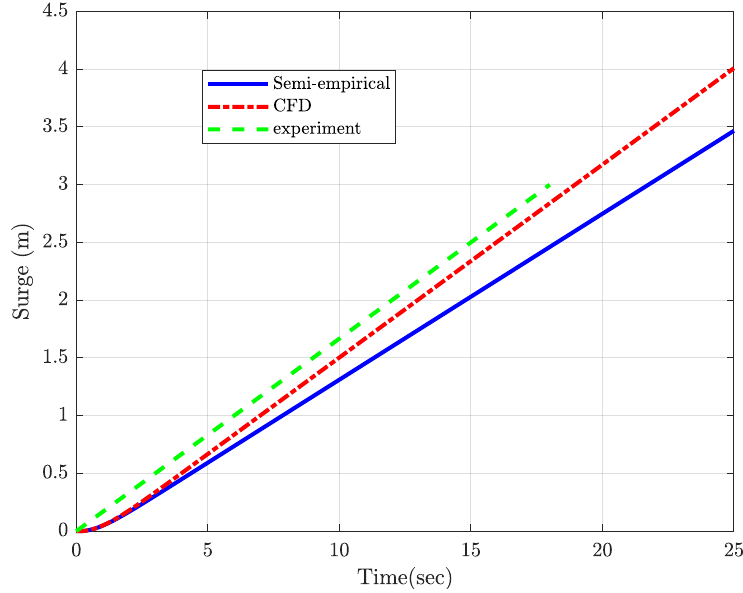
Figure 10. Surge response (developed with MATLAB [67]). An estimate of the time and cost involved in the three methods is shown in Table